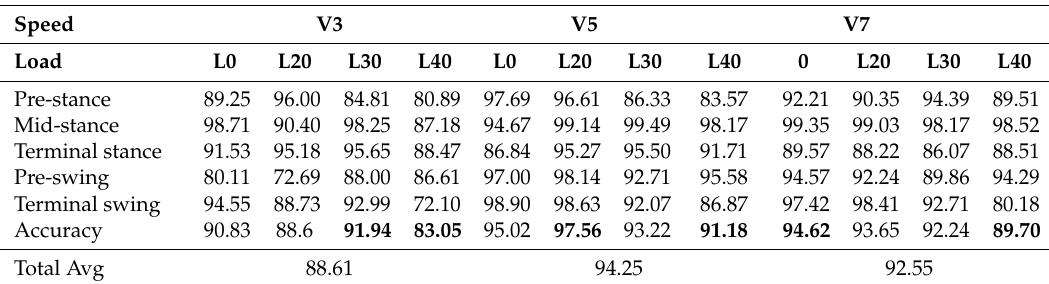
Table 1. Accuracy of recognition of the five gait phases (%), the accuracy of the gait recognition (%) under each load and speed, and the total average accuracy of the gait recognition (Total Avg) (%) among the four loads under each